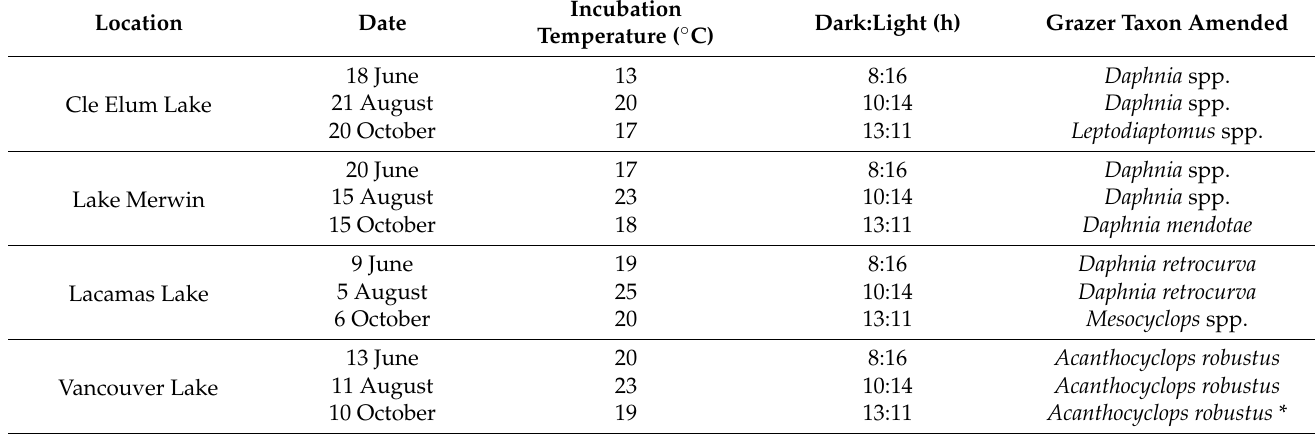
Table 1. Dates, locations, temperatures, dark:light cycles, and mesozooplankton grazer taxa amended in the incubation experiments conducted from June to October 2014. * = Bosmina spp. were most abundant in Vancouver Lake during the October experiment, but could not be amended at 5 × ambient levels; Acanthocyclops robustus was second most abundant and could be amended at 5 × ambient